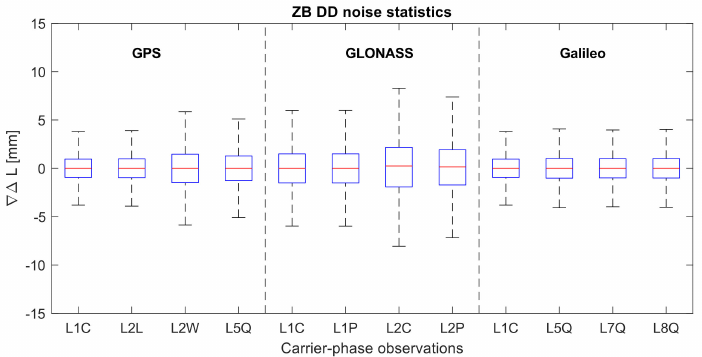
Figure 3. ZB DD time series noise statistic for carrier phase observations (2019